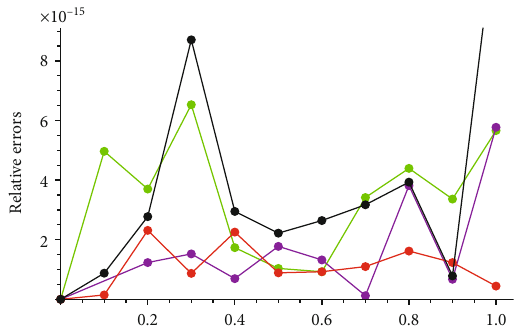
Figure 24: Relative errors of u 2 obtained by the present method with α = β = 0 (red), α = β = 0 : 5 (purple), α = 0 : 5, β = − 0 : 5 (green), and α = 2/3, β = − 1/3 (black) for Example 3.